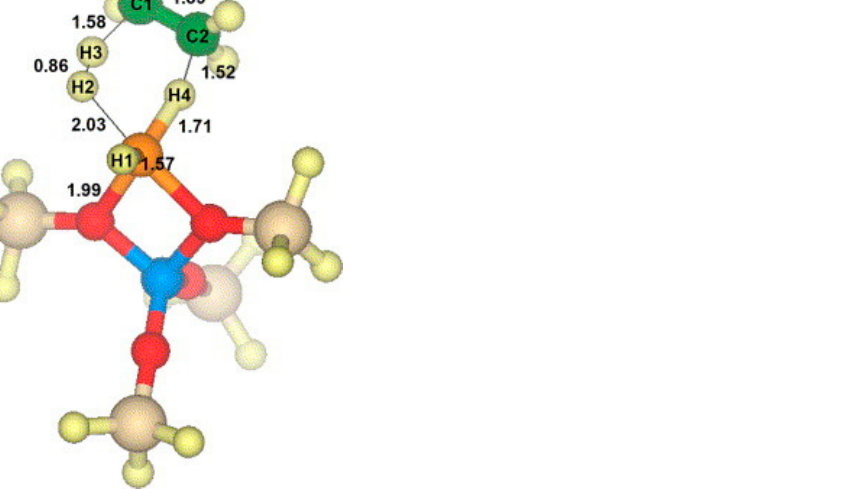
Figure 17. Transition state for the dehydrogenation reaction of ethane through the concerted mechanism. Reprinted with permission from ref [132]. Copyright 2005 Elsevier.